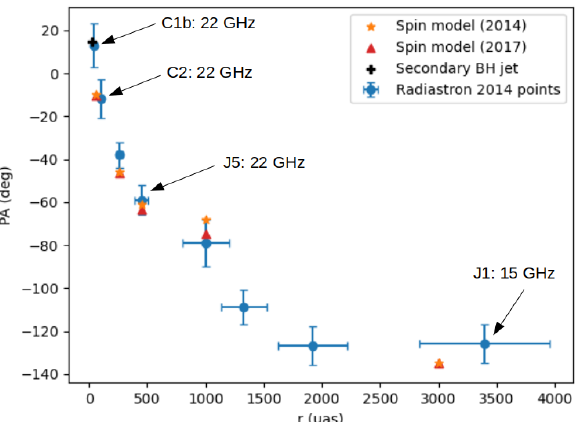
Figure 11. The distance and position angle PA of radio components in the Radioastron VLBI map by Gomez et al. [70] with error bars. The 22 GHz data are used when available. The component J1 comes from 15 GHz observations. Superposed are the theoretical positions of the corresponding components at two epochs (stars and triangles) in the spin model [74,75]. The position of the expected secondary jet is also marked (cross). Its position angle is independent of